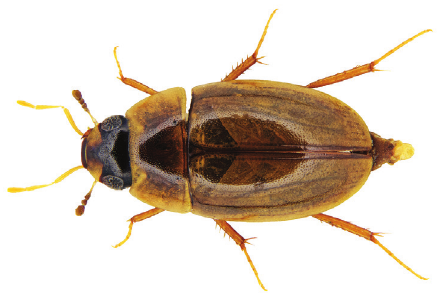
Figure 27. Enochrus ( Methydrus ) sp. 2.8 mm, iSimangaliso Wetland Park, Catalina Bay (site 32), February 2015 DT Bilton, MS Bird & R Perissinotto leg.